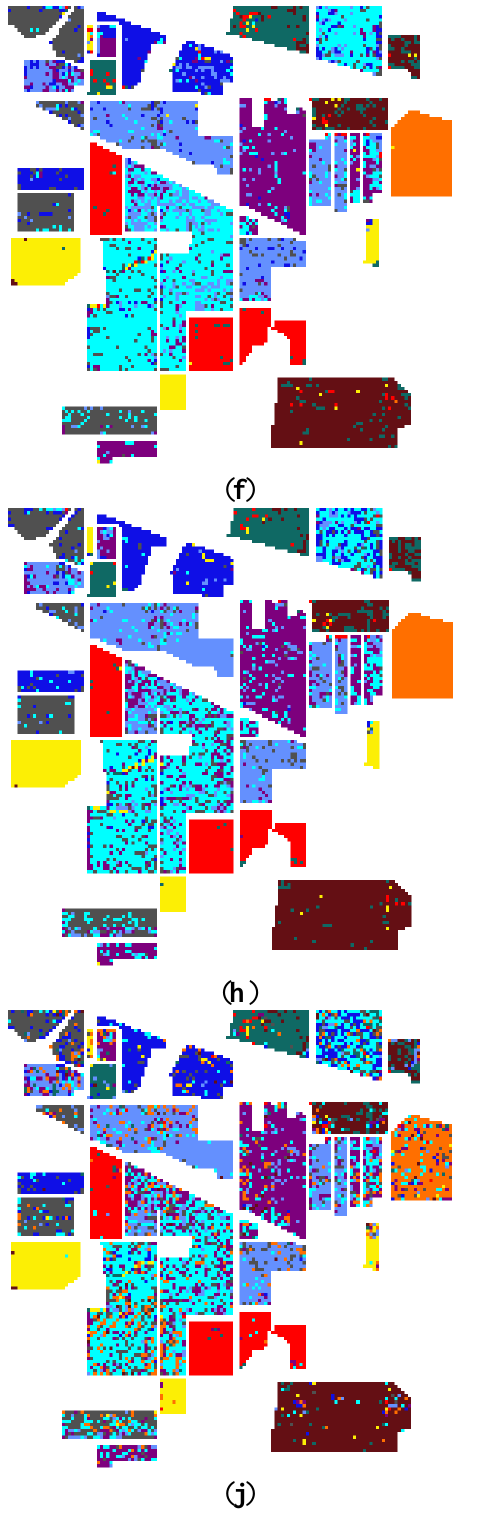
Figure 6. The classification maps of dataset IPS using various algorithms: ( a ) The ground truth; ( b ) FKNFLE; ( c ) KNFLE; ( d ) FNFLE; ( e ) NFLE; ( f ) NRS (nearest regularized subspace); ( g ) LFDA-NRS (local Fisher discriminant analysis-NRS); ( h ) LFDA; ( i ) supervised LPP; ( j ) LDA; and ( k )